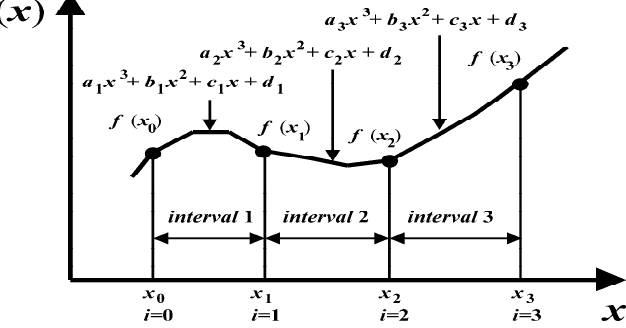
Figure 5. Notation used to derive cubic splines.